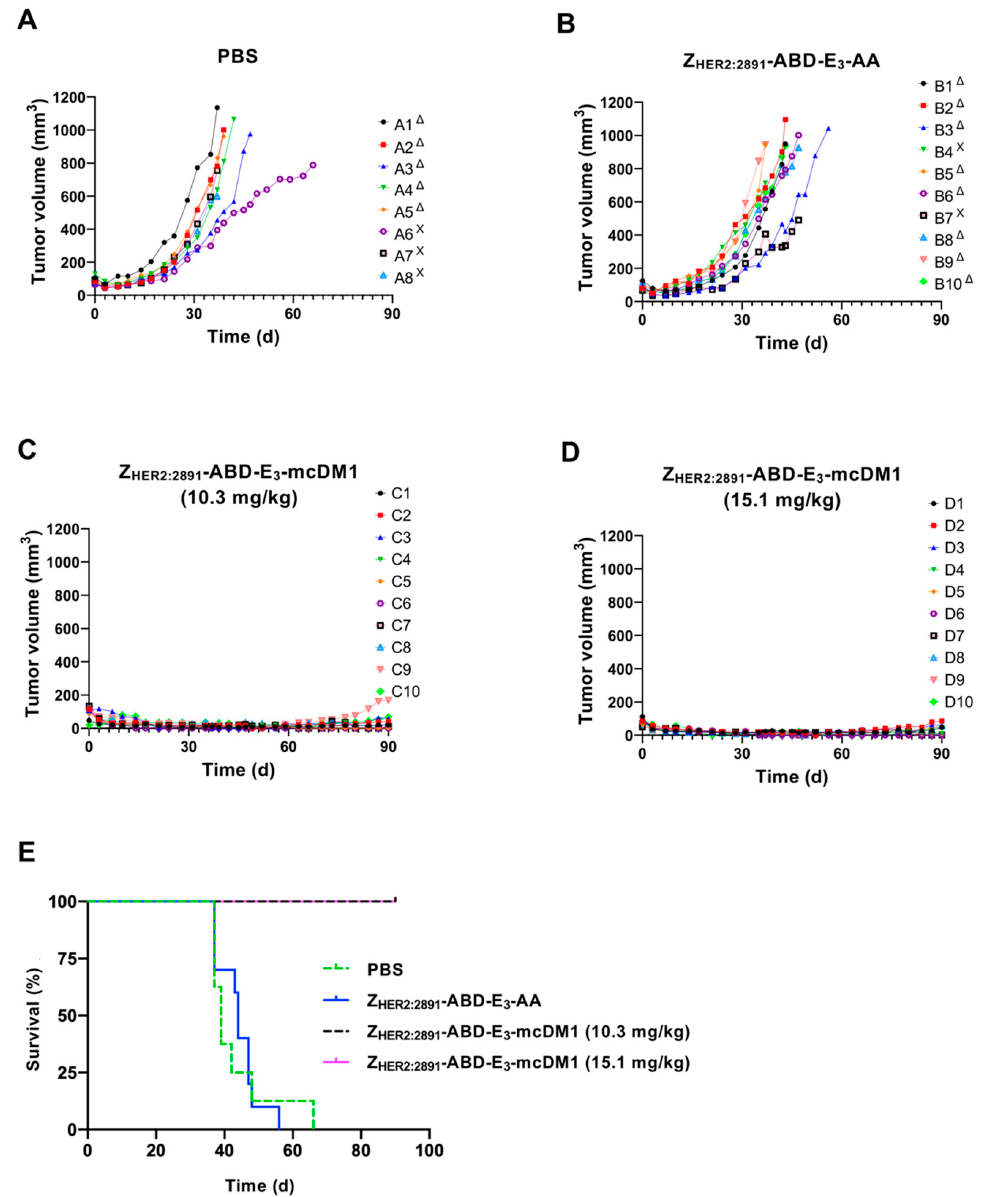
Figure 6. Experimental therapy with tumor volume growth curves for individual mice in each group. SKOV3 cells were subcutaneously implanted into the belly of nude BALB/c nu/nu mice. One week later the mice were randomized into four groups and given s.c. injections (scruff of the neck) of either PBS ( A ), 15.1 mg/kg Z HER2:2891 -ABD-E 3 -AA ( B ), 10.3 mg/kg Z HER2:2891 -ABD-E 3 -mcDM1 ( C ), or 15.1 mg/kg Z HER2:2891 -ABD-E 3 -mcDM1 ( D ). Four injections were given at day 0, 7, 14, and 21. The mice were euthanized when the volume of the subcutaneous xenografts exceeded 1000 mm 3 ( Δ ) or bleeding ulcers on the xenografts were observed ( Χ ). ( E ) Survival of the mice during the experimental therapy. At day 60, SPECT/CT imaging of HER2 expression using 99m Tc-labeled Z HER2:V2 was